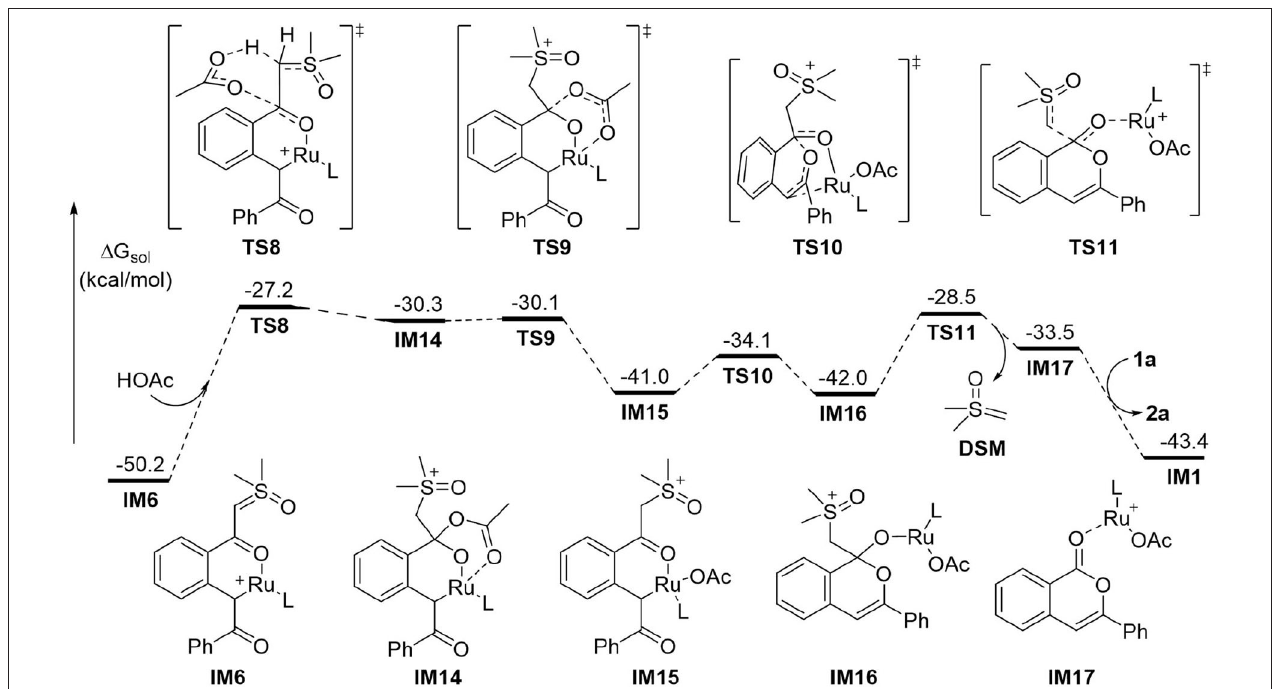
FIGURE 3 | DFT Results for the Formation of 2a from IM6 (L = p